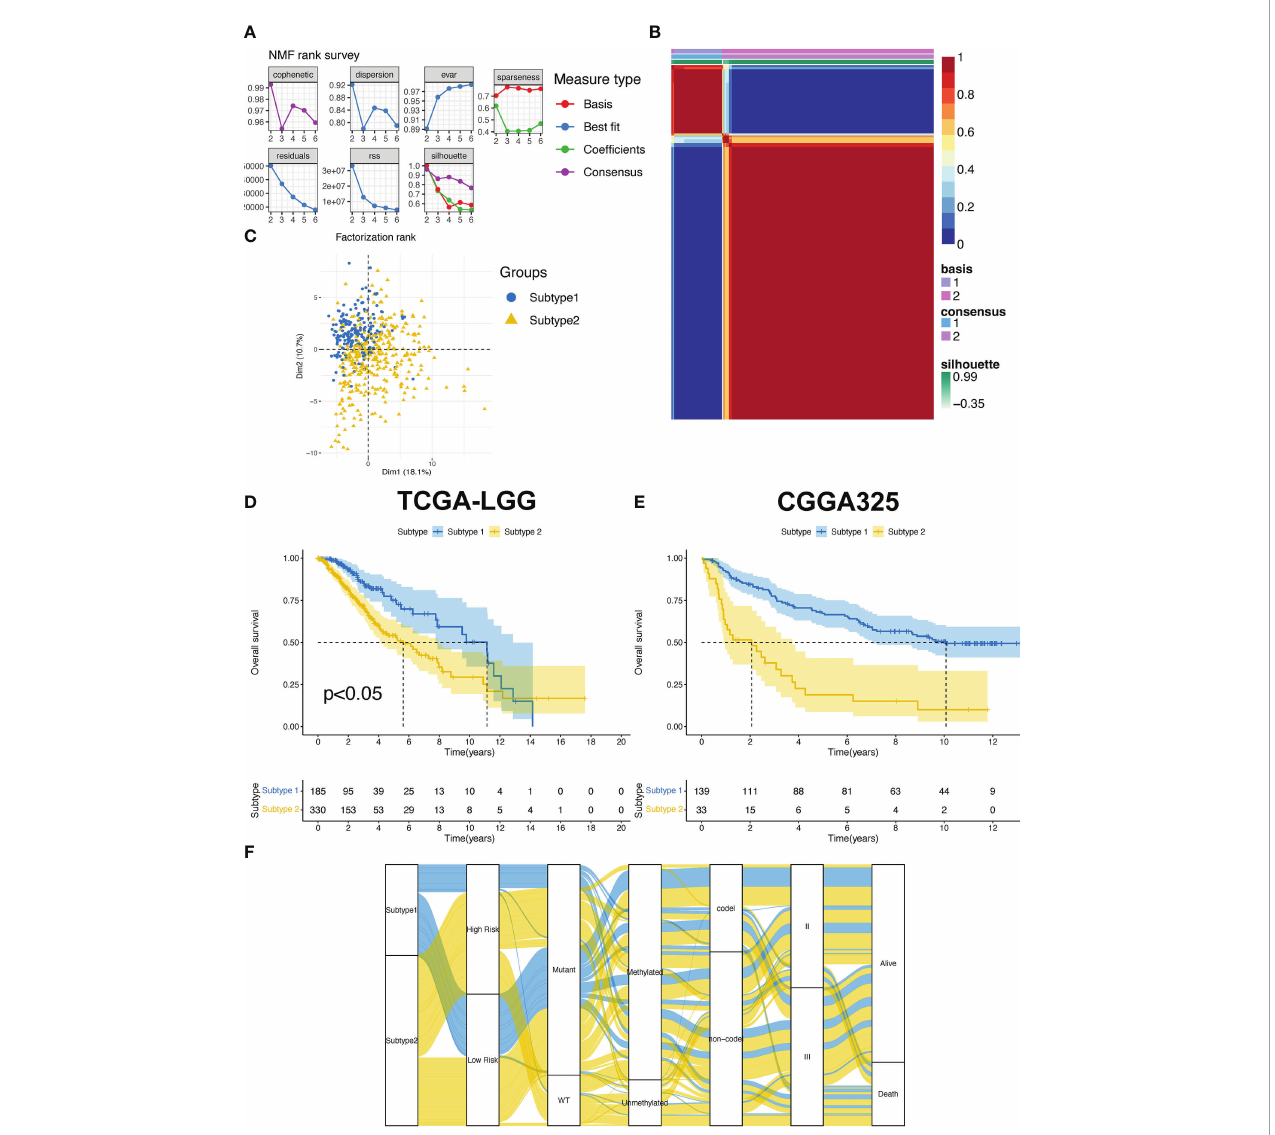
FIGURE 2 (A) The factorization rank diagram of the TPR subtype. (B) The clustering results using k=2 is shown for TCGA-LGG cohort. (C) Principal component analysis of the two subtypes in the TCGA-LGG cohort. (D, E) The overall survival rates of the two subtypes in the TCGA-LGG (D) and CGGA325 cohorts (E) . (F) The Sankey diagram exhibits the correlation between the subtype and clinical